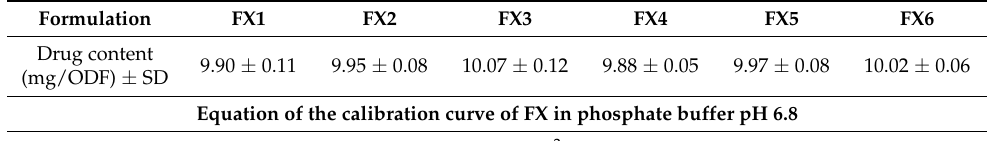
Table 7. Fluoxetine concentration in the prepared